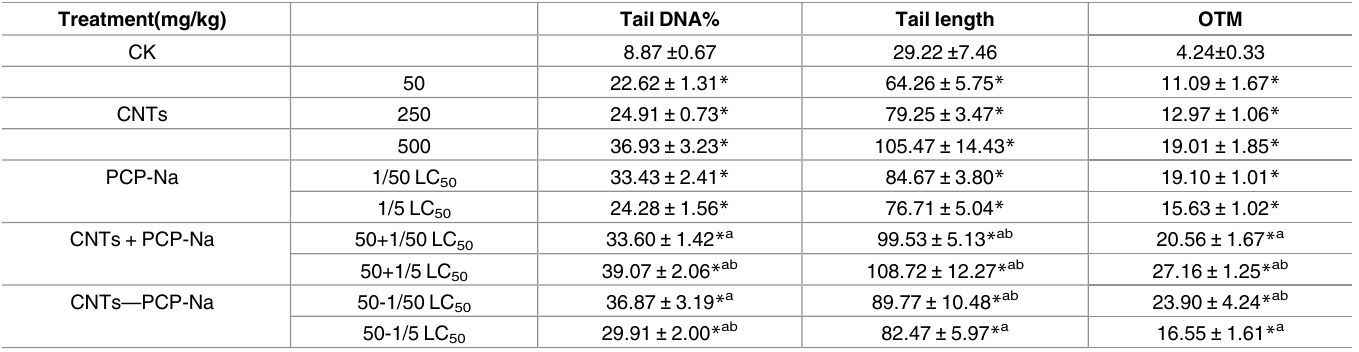
Table 3. DNA damage of earthworm coelomocytes under PCP-Na and MWCNTs exposure.